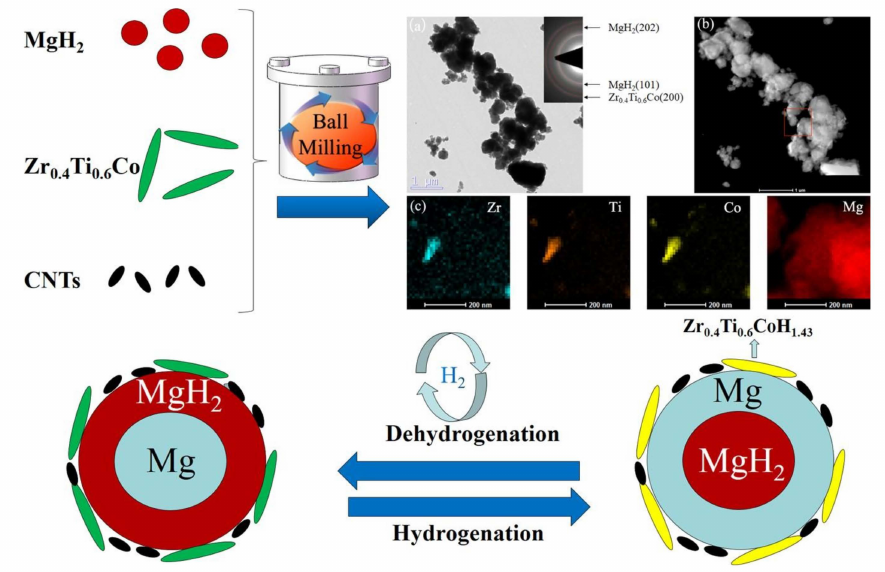
Figure 20. Preparation and investigation of MgH 2 -Zr 0.4 Ti 0.6 Co nanosheets and carbon nan- otubes [145]. (Reprinted with permission from Elsevier.)